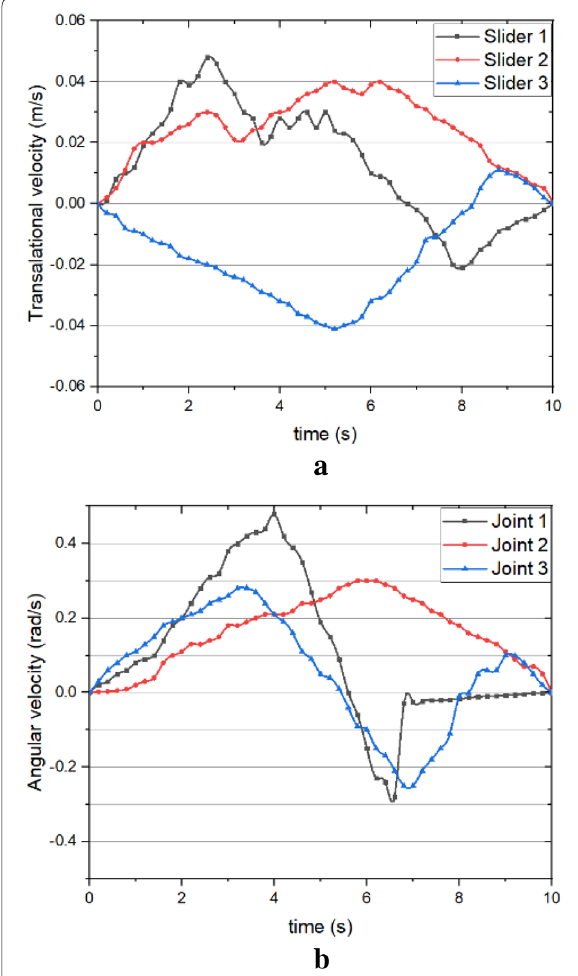
Figure 15 a Slider velocity vs time, b Angular velocity vs time